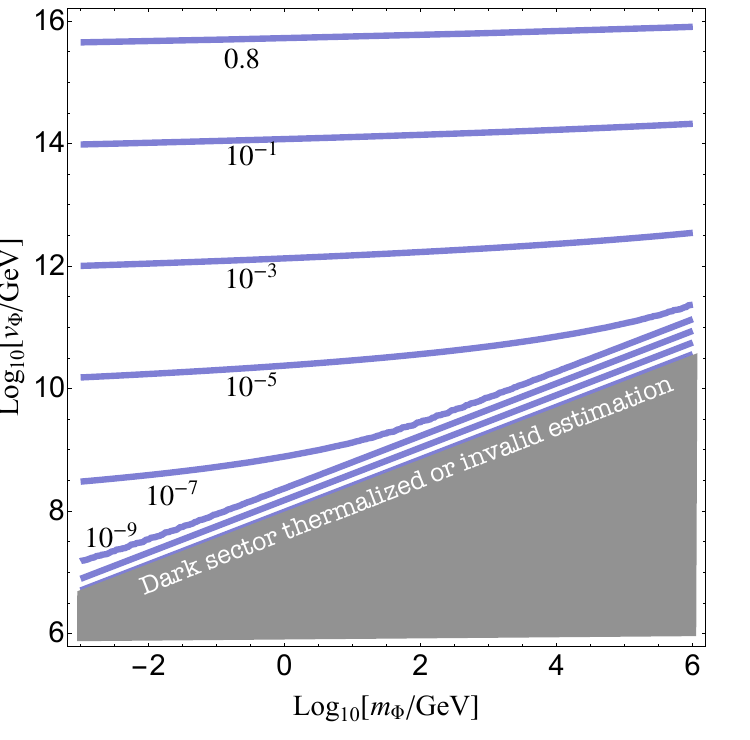
osc , on ( m Φ , v Φ ) plane for λ 2 s m Φ v 2 Φ